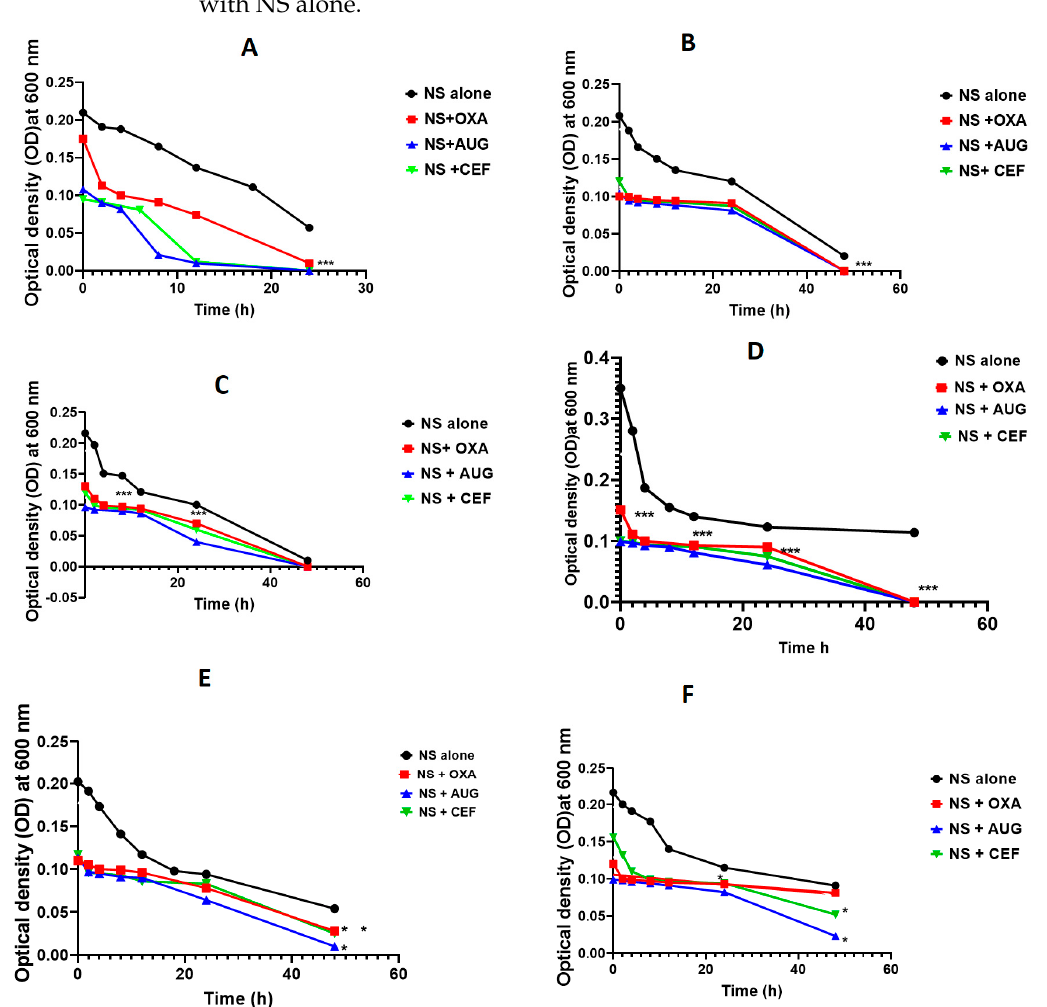
Figure 3. Time–kill assay curves of 7.5 µg/mL concentration of Nigella sativa (NS) alone and in combination with antibiotics against ( A ) MRSA 1, ( B ) MRSA 4, and ( C ) MRSA 5 bacterial isolates. ( A ) *** Represents significant values at p < 0.0039 for NS + OXA, p < 0.0016 for NS + AUG and p < 0.0142 for NS + CEF; ( B ) *** Represents significant values at p < 0.0113 for NS + OXA, p < 0.0061 for NS + AUG and p < 0.0053 for NS + CEF; ( C ) *** Represents significant values at p < 0.0179 for NS + OXA, p < 0.0336 for NS + AUG and p < 0.0180 for NS + CEF. Time–kill assay curves of 5.0 µg/mL concentration of Nigella sativa (NS) alone and in combination with antibiotics against ( D ) MRSA 1, ( E ) MRSA 4, and ( F ) MRSA 5 bacteria isolates. ( D ) *** Represents significant values at p < 0.0408 for NS + OXA, p < 0.0200 for NS + AUG and p < 0.0494 for NS + CEF; (b) * Represents significant values at p < 0.0331 for NS + OXA, p < 0.0083 for NS + AUG, and p < 0.0254 for NS + CEF; ( F ) * Represents significant values at p < 0.0161 for NS + OXA, p < 0.0019 for NS + AUG and p < 0.0022 for NS +